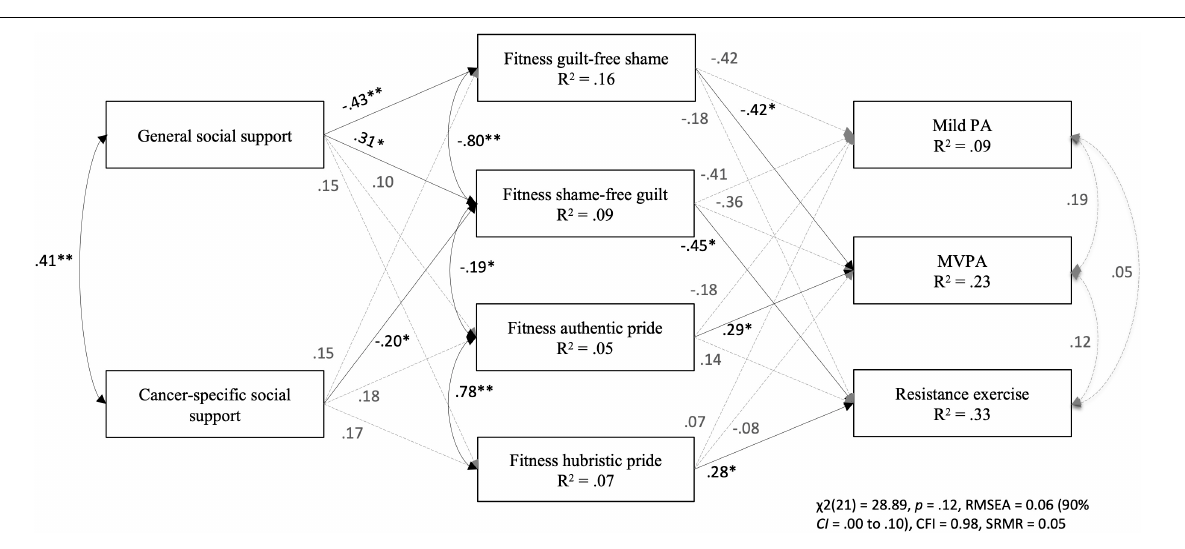
FIGURE 2 | Standardized path coefficients and explained variance of the model in predicting social support, fitness-related emotions, and physical activity. Note. Covariates included in the model are age, gender, and time since diagnosis. Variance explained for each endogenous variable are reported within the observed variable boxes. None of the indirect effects were significant. PA = physical activity; MVPA = moderate-to-vigorous physical activity. * p < 0.05; ** p <